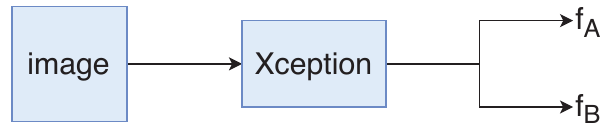
Figure 6. Fully shared bilinear model based on